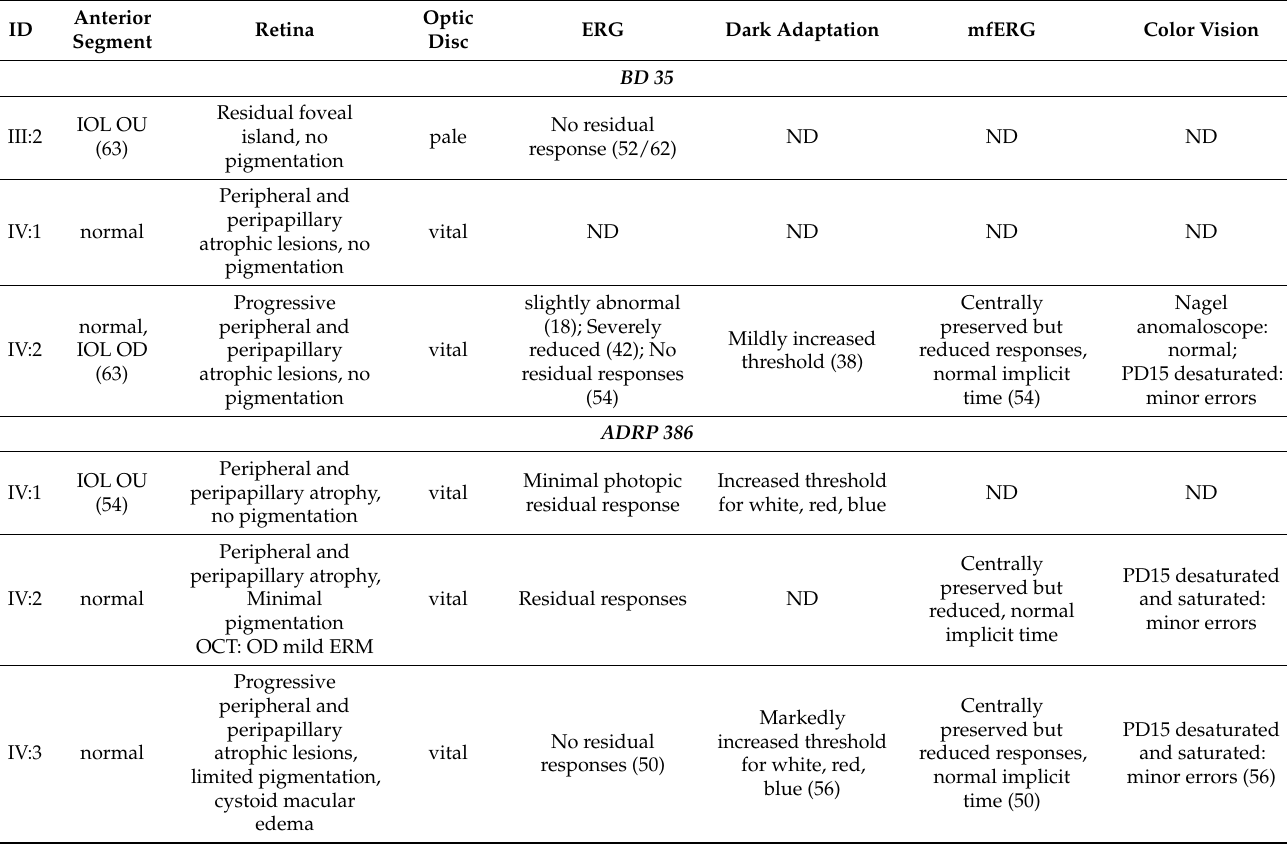
Table 2. Patient data: Anterior segment, retinal and functional